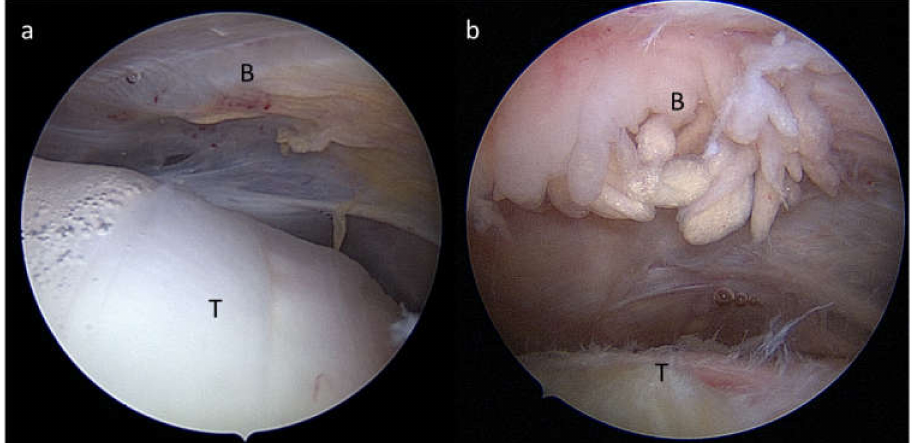
Figure 2. Arthroscopic view from a posterior portal during arthroscopy of a right shoulder showing ( a ) a normal subacromial/subdeltoid bursa (B) and healthy tendon (T) and ( b ) a severe hypertrophic subacromial bursitis (B) and fraying of the supraspinatus tendon